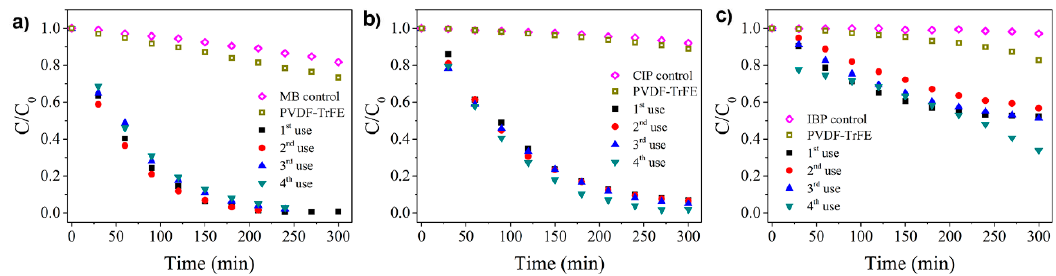
Figure 4. Decrease of the content of ( a ) MB, ( b ) CIP, and ( c ) IBP during four cycles of photocatalytic treatment by 8% TiO 2 /PVDF-TrFE sample under UV irradiation. CIP, ciprofloxacin; IBP, ibuprofen.